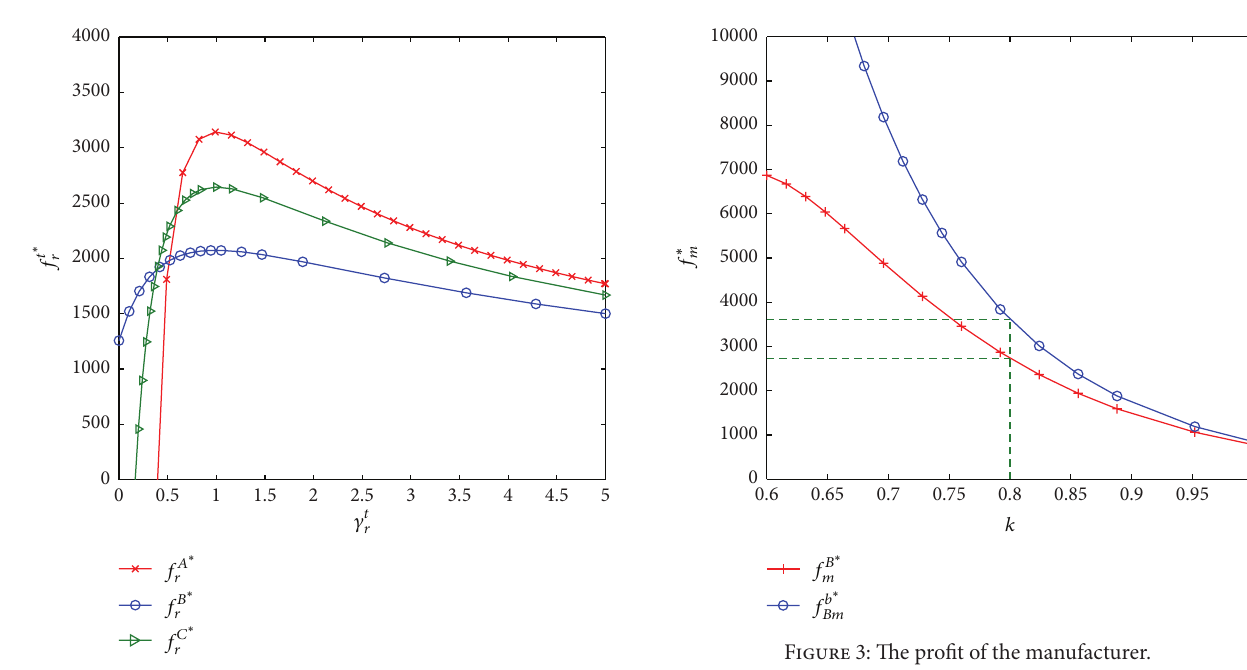
Figure 2: With revenue sharing contracts.